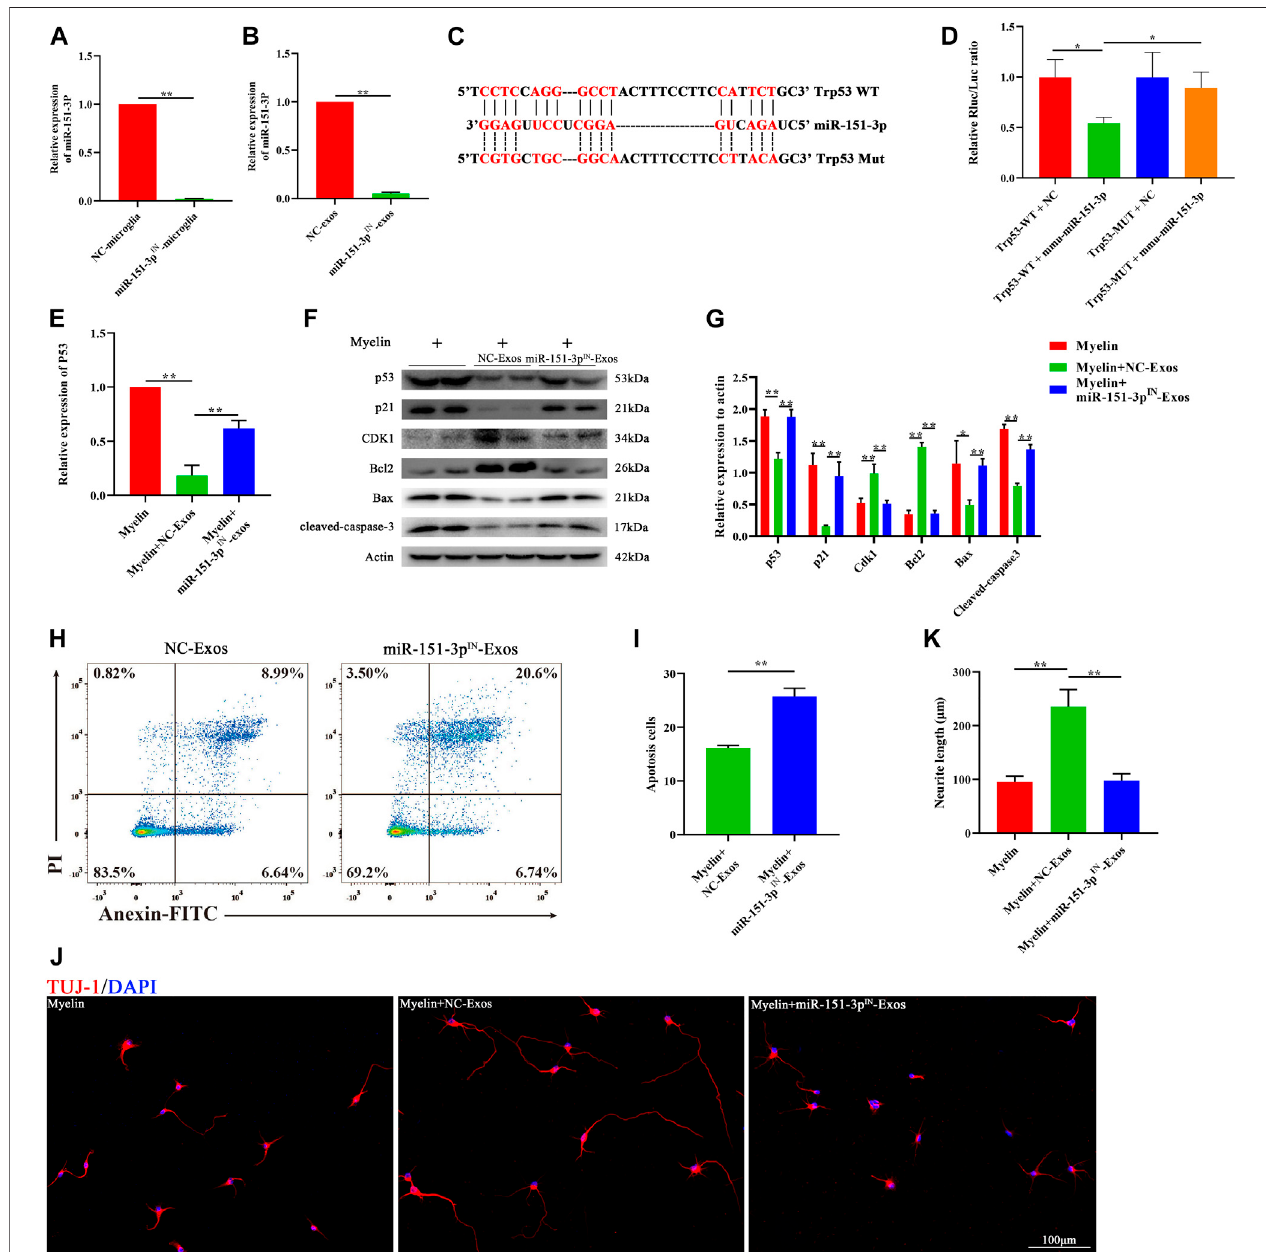
FIGURE 6 | Microglia-Exos rescue neuron apoptosis and promote neurite growth via suppressing p53/p21/CDK1 signaling through miR-151-3p . (A) Relative expression of miR-151-3p of negative control and miR-151-3p inhibitor transfected microglia cells (NC-microglia and miR-151-3p IN -microglia) by qRT-PCR. N (cid:1) 3 per group. (B) Relative expression of miR-151-3p of exosomes derived from negative control and miR-151-3p inhibitor transfected microglia cells (NC-Exos and miR-151- 3p IN -Exos) by qRT-PCR. N (cid:1) 3 per group. (C) Complementary sequences between miR-151-3p and the 3 ′ UTR of Trp53. (D) Relative luciferase activities of the p53-wt + negative control group, p53-wt + miR-151-3p group, p53-mut + negative control group, and p53-mut + miR-151-3p group. N (cid:1) 3 per group. (E) Relative expression of p53 of myelin debris, myelin debris + microglia-Exos, and myelin debris + miR-151-3p IN -Exo – treated groups by qRT-PCR. N (cid:1) 3 per group. (F) Western blotanalysisofp53,p21,CDK1,apoptosis-relatedproteinBax,andcleaved-caspase-3andanti-apoptosisproteinBcl2inmyelindebris,myelindebris+Microglia-Exos, and myelin debris + miR-151-3p IN -Microglia-Exo – treated groups. (G) Quanti fi cation of proteins ’ relative expression in (F) . N (cid:1) 3 per group. (H) Flow cytometry of Annexin/PIstaininginmyelindebris,myelindebris+Microglia-Exos,andmyelindebris+miR-151-3p IN -Microglia-Exo – treatedgroups. (I) Quanti fi cation oftheapoptosis rate of neurons in (D) . N (cid:1) 3 per group. (J) Representative fl uorescent images of neuron staining with Tuj-1 (red) of myelin debris, myelin debris + Microglia-Exos, and myelin debris + miR-151-3p IN -Microglia-Exo – treated groups. Scale bar: 100 μ m. (K) Quanti fi cation of neurite length in (J) . N (cid:1) 5 per group. Data are presented as the mean ± SD. * p < 0.05, ** p < 0.01.